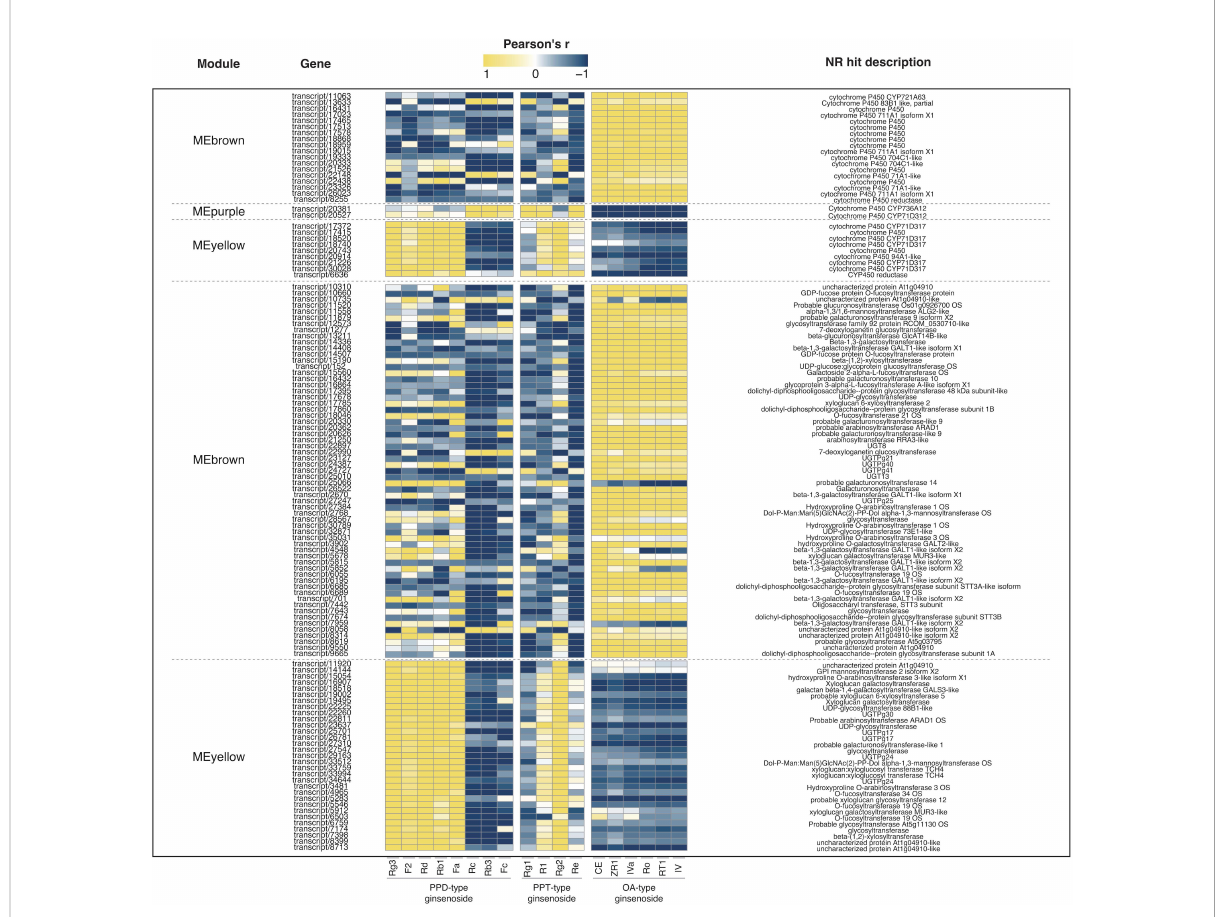
FIGURE 7 Pearson correlation analysis of target transcripts expression patterns and ginsenoside contents in different samples. Heatmap to present the Pearson ’ s correlation of CYPs and UGTs annotated transcripts from 5 selected modules with investigated